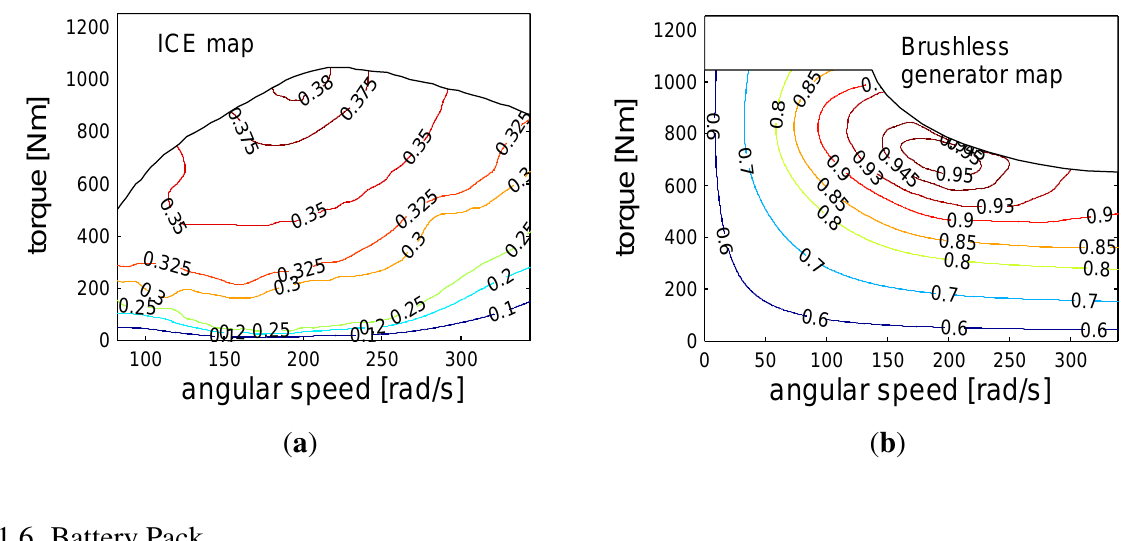
Figure 3. The efficiency maps of the ( a ) internal combustion engine (ICE) unit and of the ( b ) brushless electric